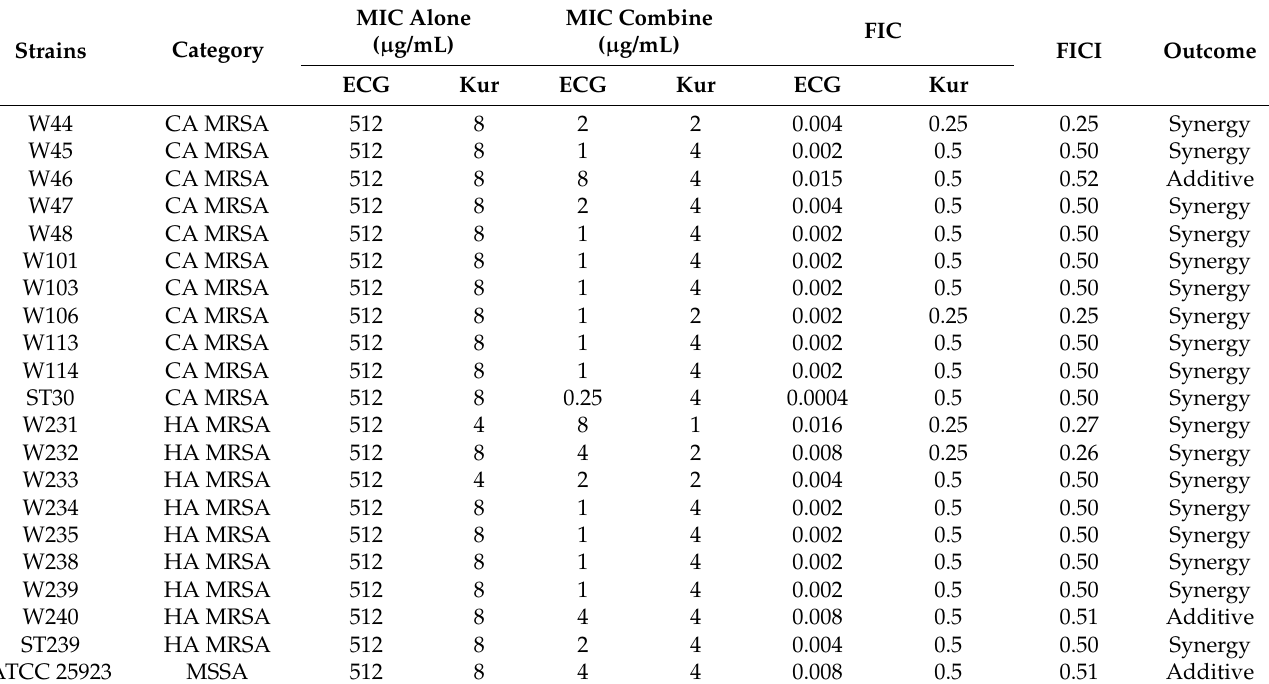
Table 1. Minimum inhibitory concentrations (MIC) ( µ g/mL) and fractional inhibitory concentration indices (FICI) of kuraridin (Kur) and epicatechin gallate (ECG) against community-associated (CA) and hospital-associated (HA) MRSA strains.